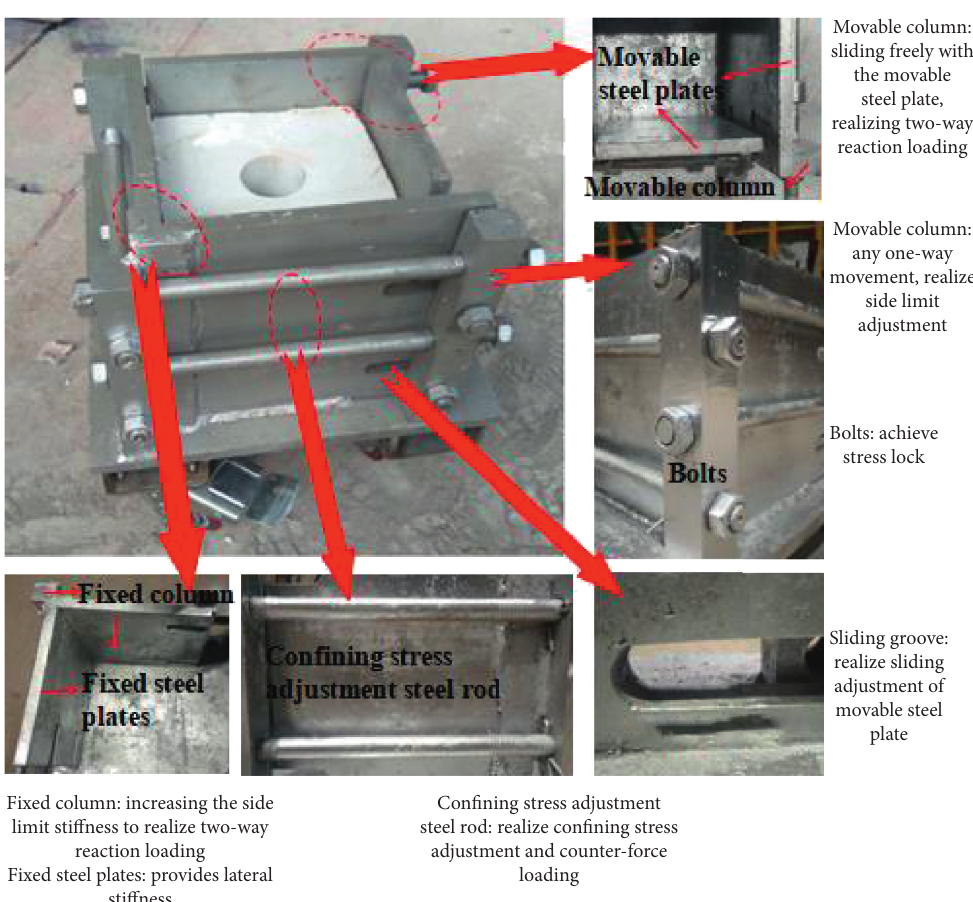
Figure 3: Detailed structure and explanatory diagram of in situ stress